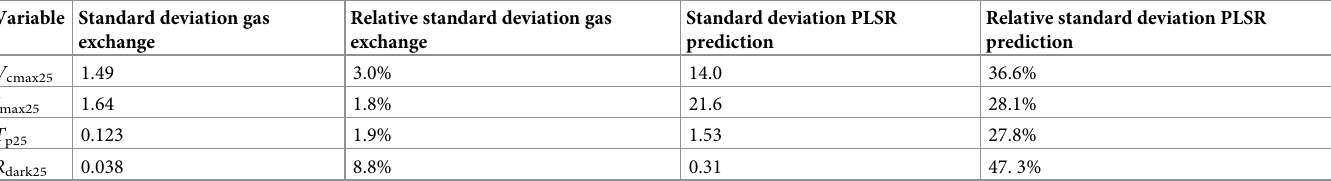
Table 2. Uncertainties associated with the gas exchange measurements and the PLSR